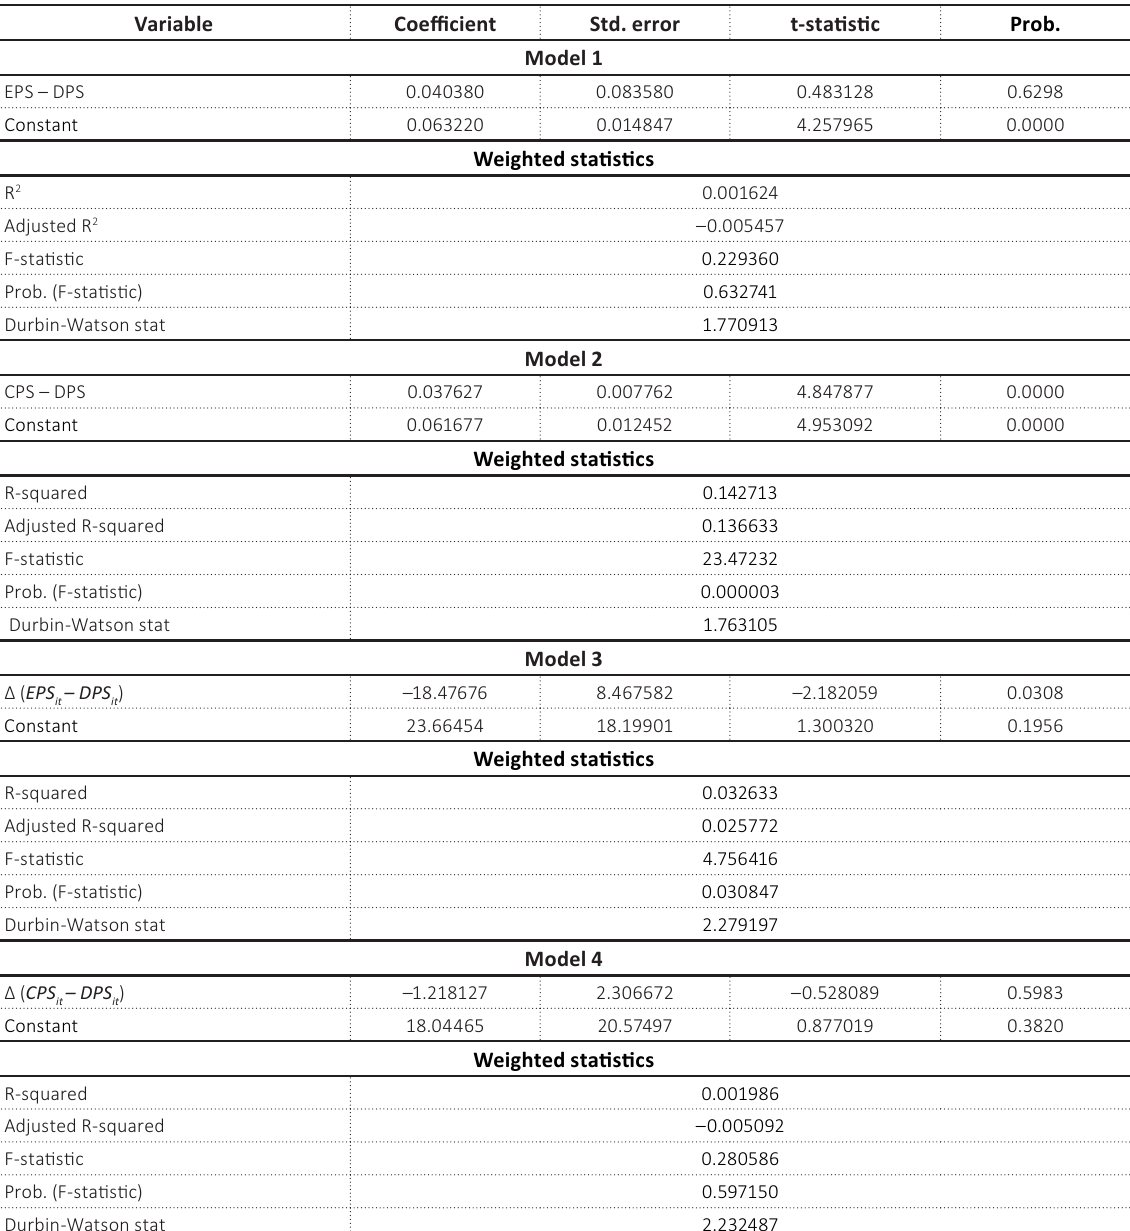
Table 10. Random effect